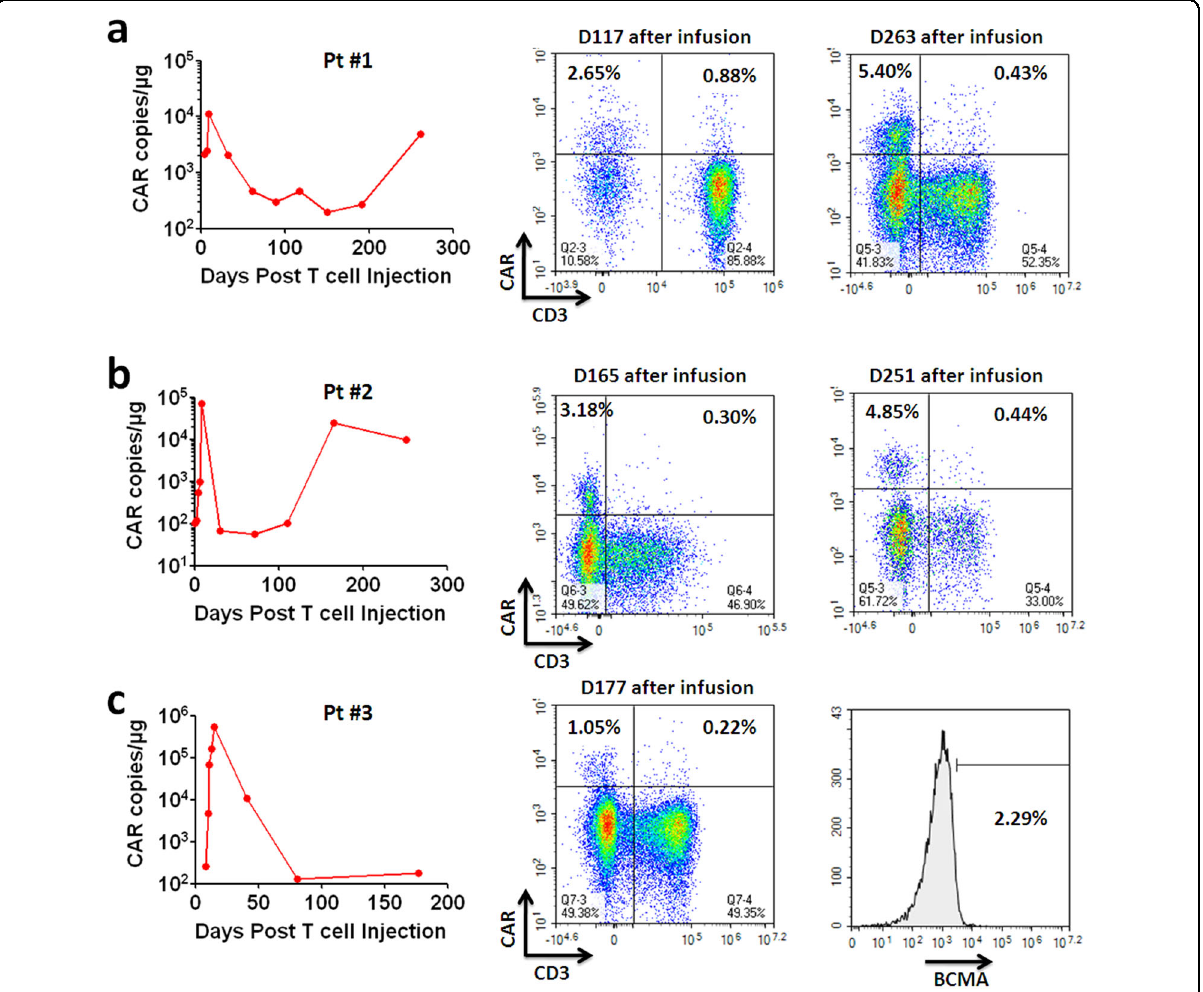
Fig. 5 Persistence and re-expansion of CRISPR-edited anti-CD19 or anti-BCMA CART-aIL6/IL1RA with GM-CSF/TCR KO in patients. a – c Left panel, kinetics of CAR vector copies in the blood of treated patients and frequencies of CRISPR-edited CD3 – CART cells. Right panel, analysis of CD3 + and CD3 – CAR + T cells in patient samples during long-term follow-up. c BCMA expression on lymphocytes of peripheral blood in patient #3 at D177 post